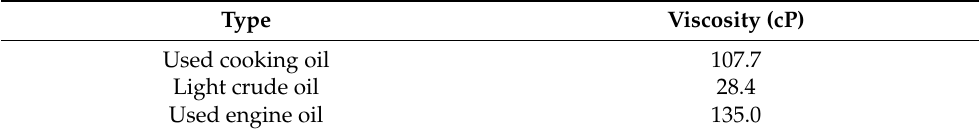
Table 2. Average values of the viscosities of oils.